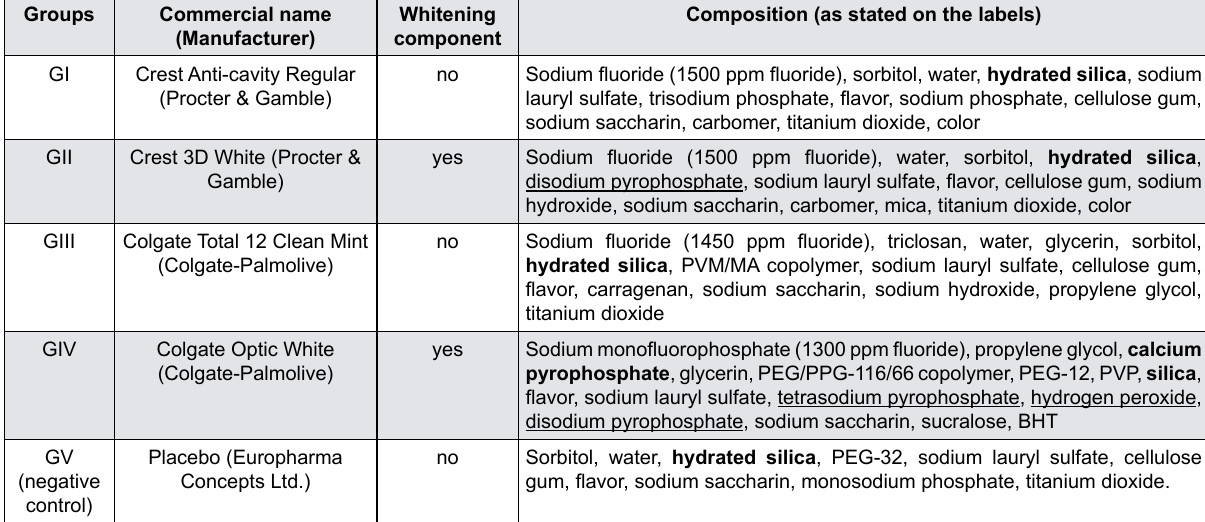
Figure 1- Composition of the dentifrices